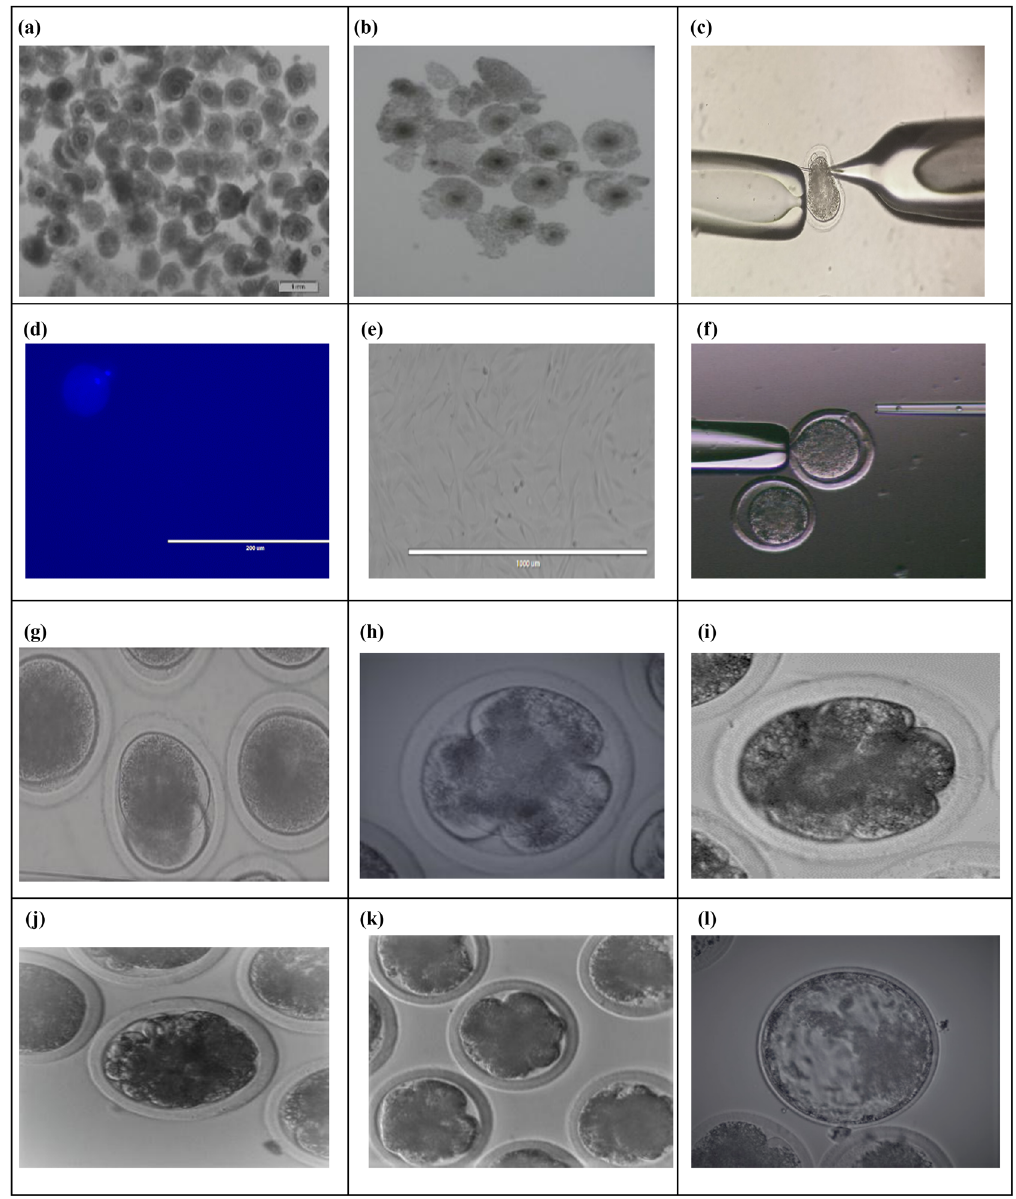
Figure 1: ( a ) Immature oocyte, ( b ) mature oocyte, ( c ) oocyte with FPB after 24 h ( the arrow = 1st polar body ) and oocyte cutting, ( d ) the nucleus was extracted and stained, and then examined under fl uorescence microscopy, ( e ) donor cells from Arabian Oryx, ( f ) injection somatic cell, ( g ) 2 cell stage, ( h ) = 4 cell stage, ( i ) = 8 cell stage, ( j ) = 16 cell stage, ( k ) morula stage, and ( l ) blastocyst